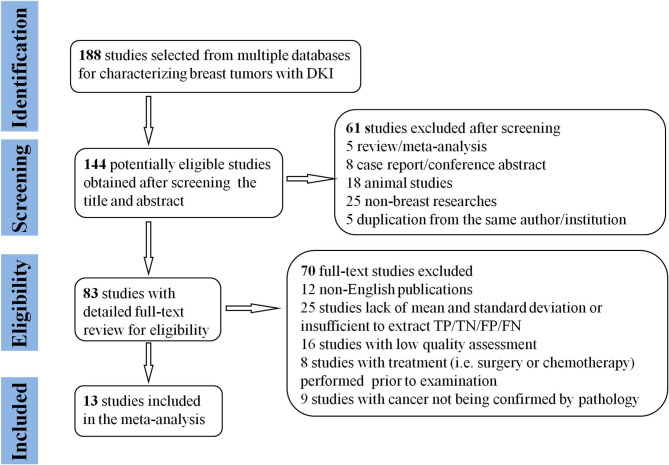
Flowchart detailing the study selection process. Thirteen studies that met the inclusion criteria were included. FN, false negative; FP, false positive; TN, true negative; TP, true positive.